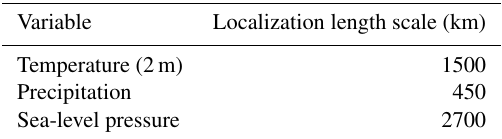
Table 1. Defined localization length scale